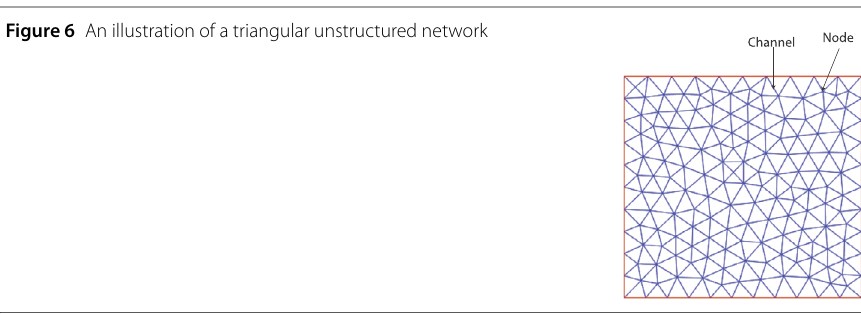
Figure 6 An illustration of a triangular unstructured network